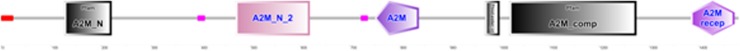
Functional domains of Hilsa A2ML protein (Consensus), determined by SMART tool.Six functional domains are shown with significant cutoff values i.e A2M_N (position 126–221; E value: 4e-17), A2M_N_2 (498–647; E: 9.23e-39), A2M (749–838; E: 1.19e-41), Thiol-ester_cl (999–1028; E: 4e-15), A2M_comp (1048–1303; E: 1.1e-65) and A2M_recep (1412–1500; E: 1.05e-33).